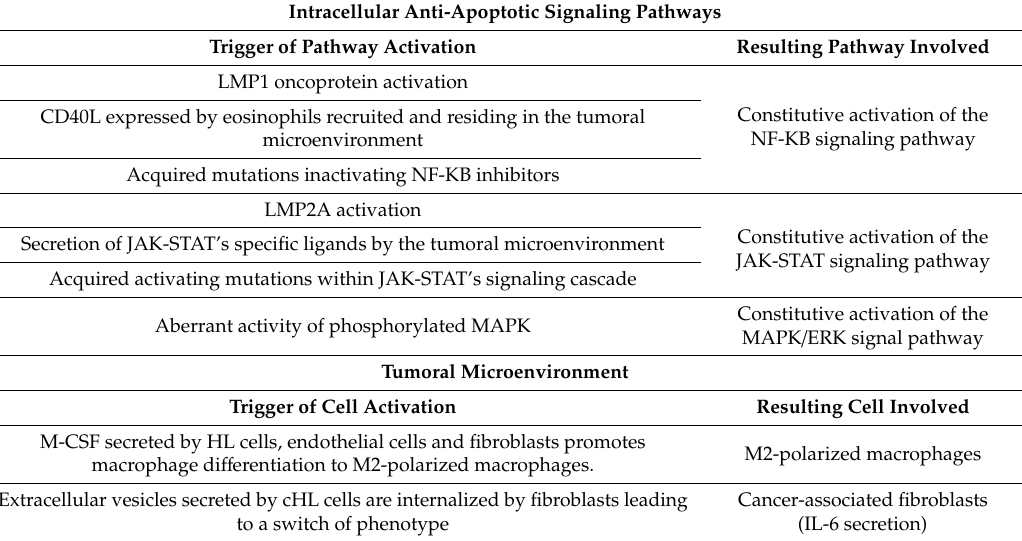
Table 1. Review of mechanisms involved in classical Hodgkin lymphoma (cHL) enhanced cell survival, apoptosis resistance, and